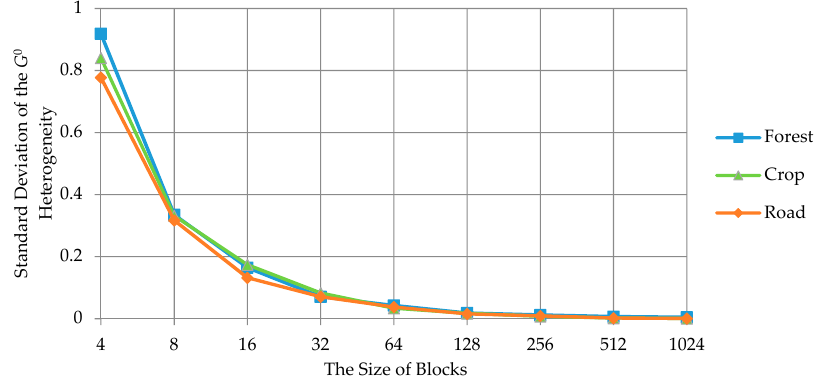
Figure 11. Standard deviation of the normalized G 0 heterogeneity, as a function of block size.